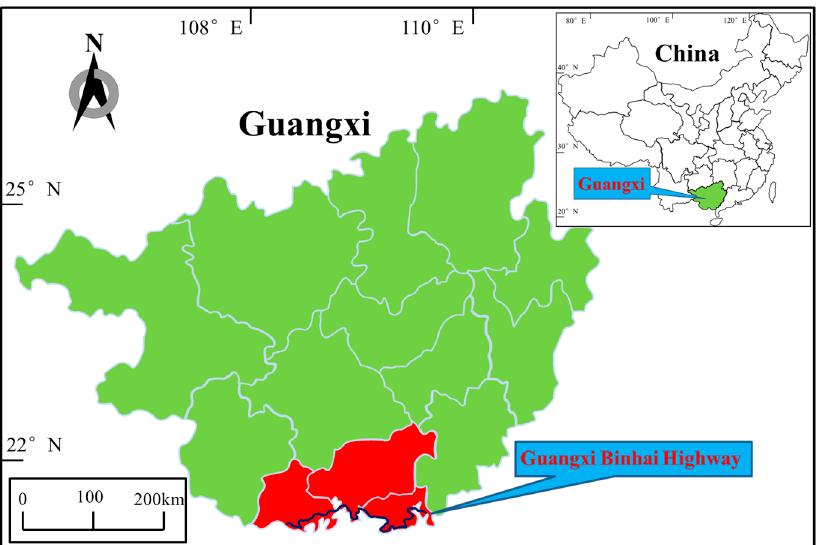
Figure 5. Location of the Guangxi Binhai Highway within China.